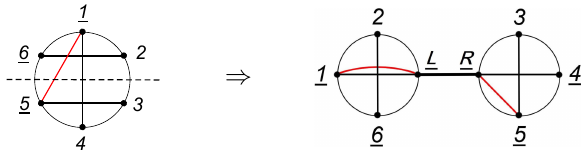
Figure 8 . A ( I 6 : 14 , 26 , 35) diagram and its factorization